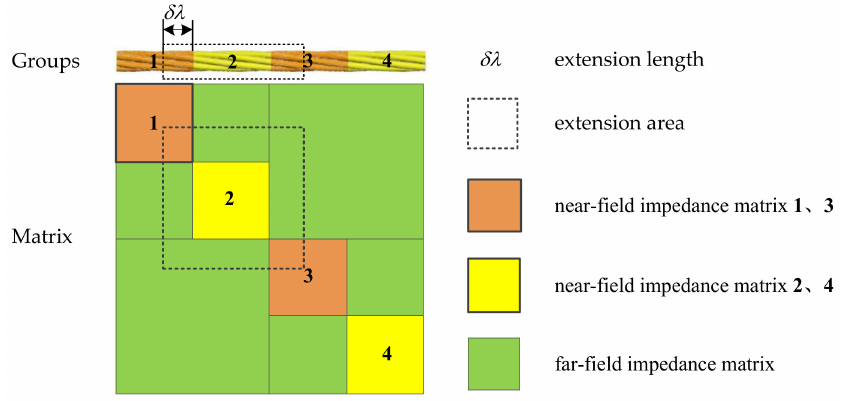
Figure 3. Extended groups and matrix in the CM